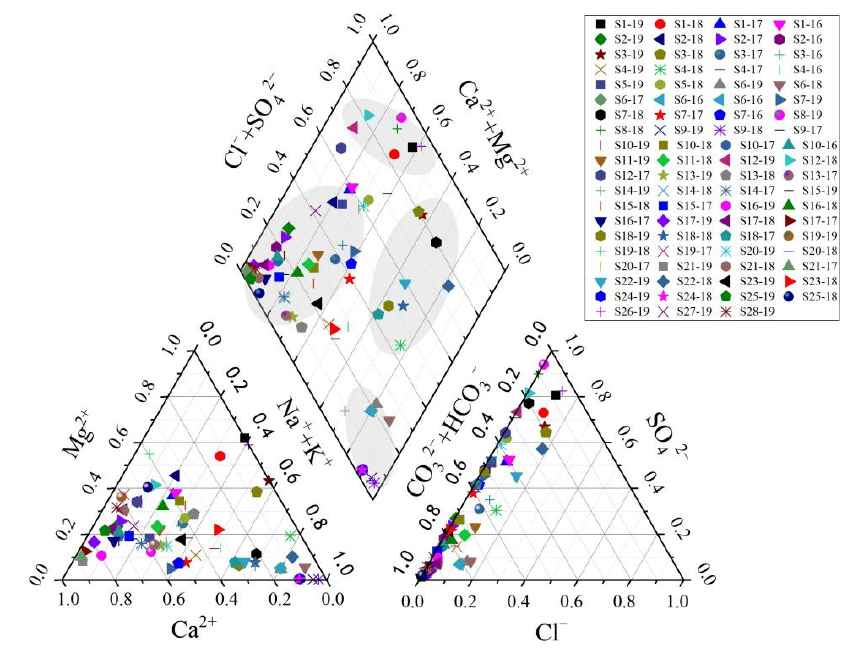
Figure 3. Piper diagram showing major ion chemistry of the sampled points.